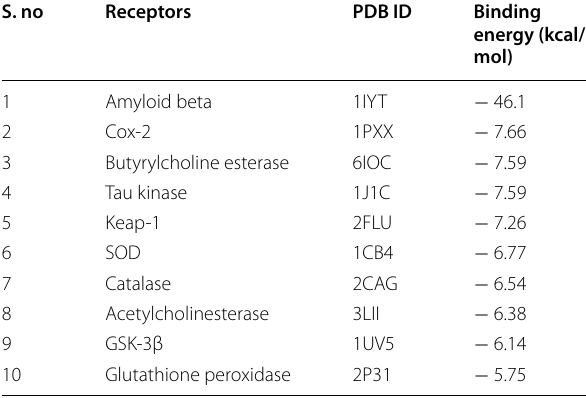
Table 8 Predicted toxicity risks